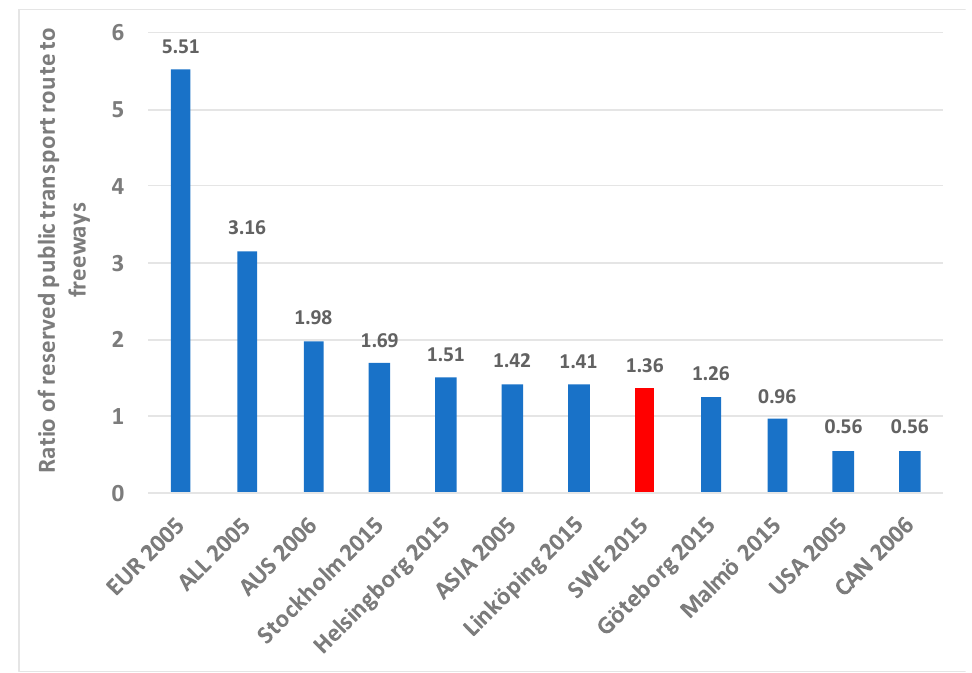
Figure 16. Ratio of reserved public transport route to freeways in five Swedish cities (2015) compared to a sample of global cities (2005–2006).